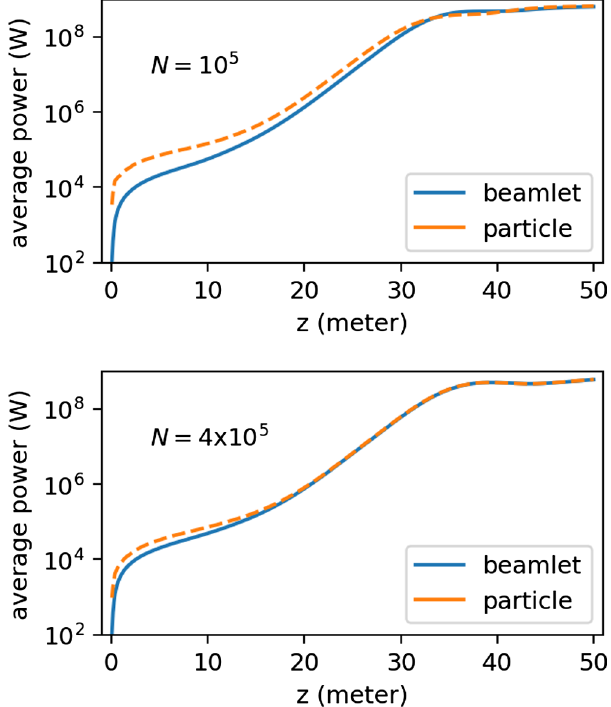
FIG. 6. Illustration of artificial shot-noise due to particle migration. Same parameters used as in Fig. 5. Blue is from the beamlet migration. Dashed orange is from the individual particle migration. Number of macroparticles are denoted in text boxes.